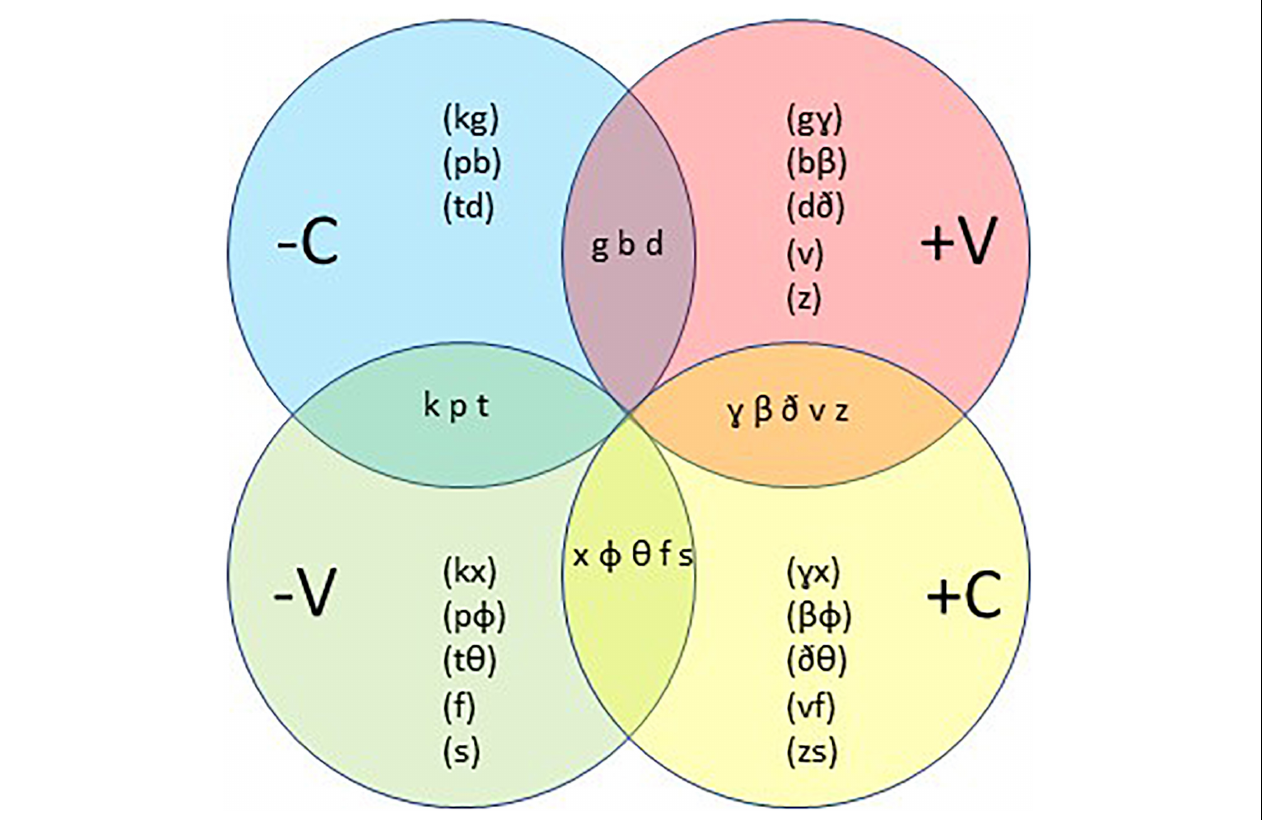
FIGURE 10 | Representations of consonants. The circles refer to representations, their intersections to the physical